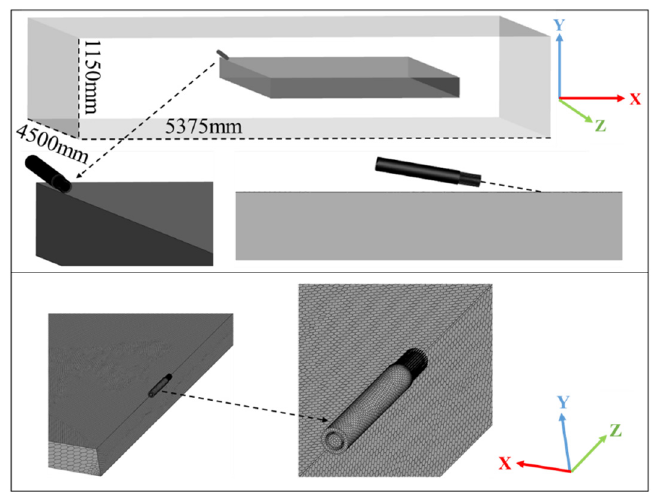
Figure 1. Three-dimensional geometrical model and three-dimensional grid model.